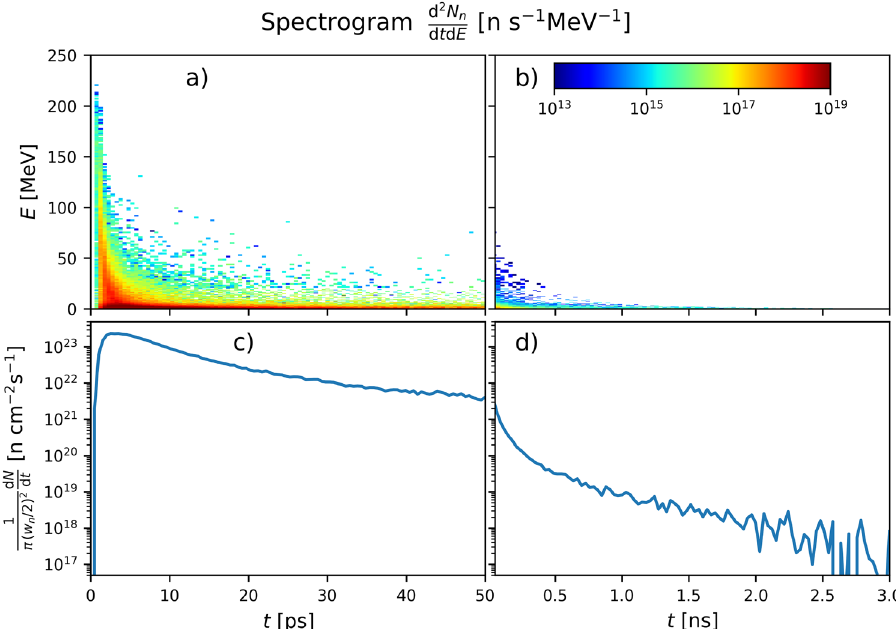
Figure 8. Temporal variations in the neutron source. ( a , b ) Time-resolved energy spectrum and ( c , d ) instantaneous flux of the neutrons crossing the rear side of the converter. Neutrons are here generated by sending the proton beam #3 into a 100- µ m-thick Pb converter. Panels ( a , c ) detail the variations in the